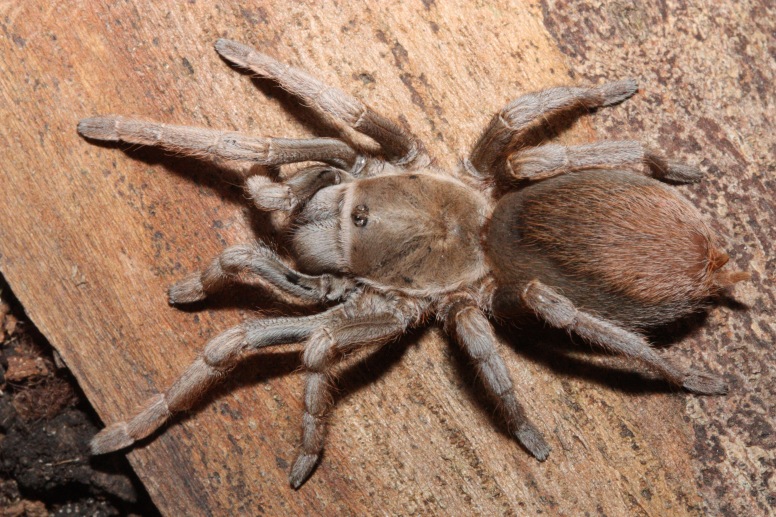
Sandinista
lanceolatum (Simon, 1891) female from Granada, Granada department, Nicaragua. Photo: Stuart J. Longhorn.